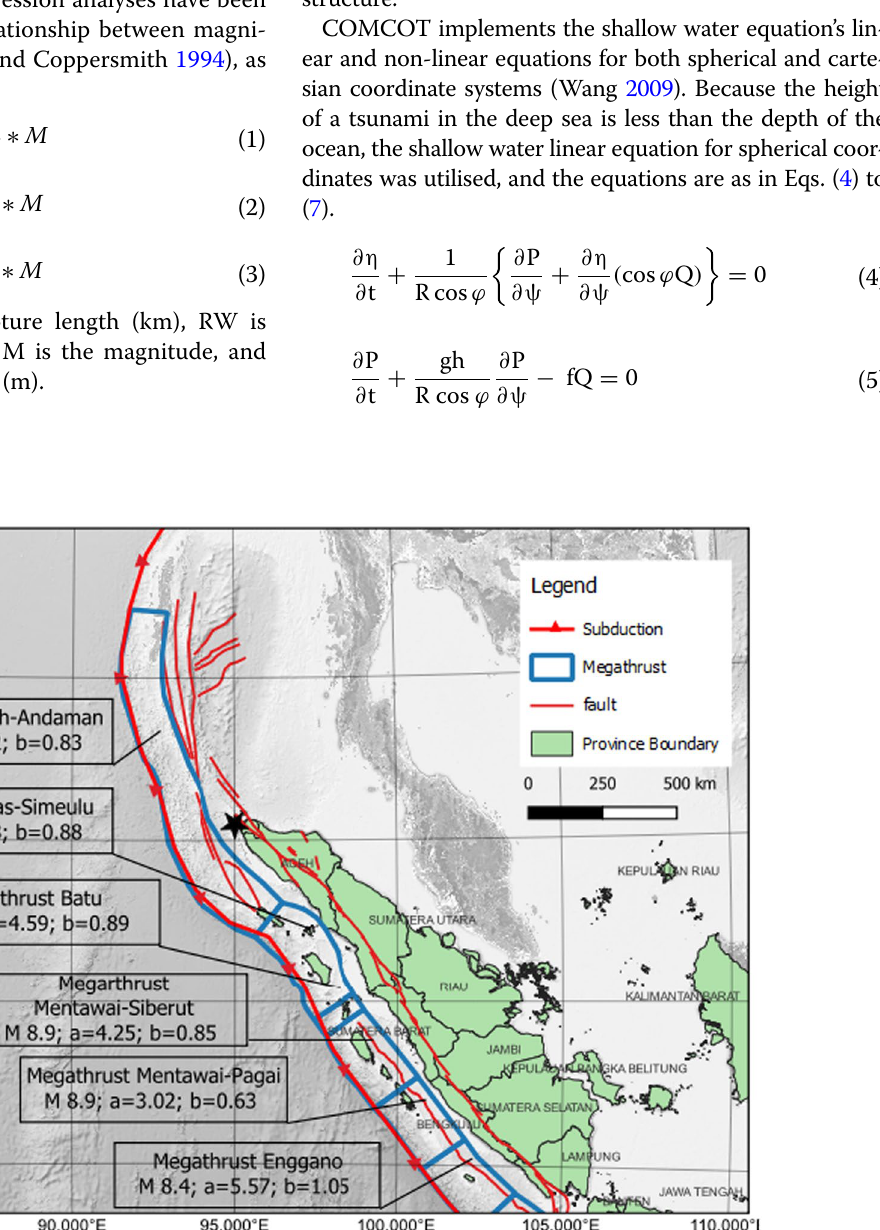
Fig. 2 Fault Segmentation and M maks of Subduction around Sumatra Island, Indonesia (Tim Pusat Studi Gempa Nasional 2017); the black star indicates the study